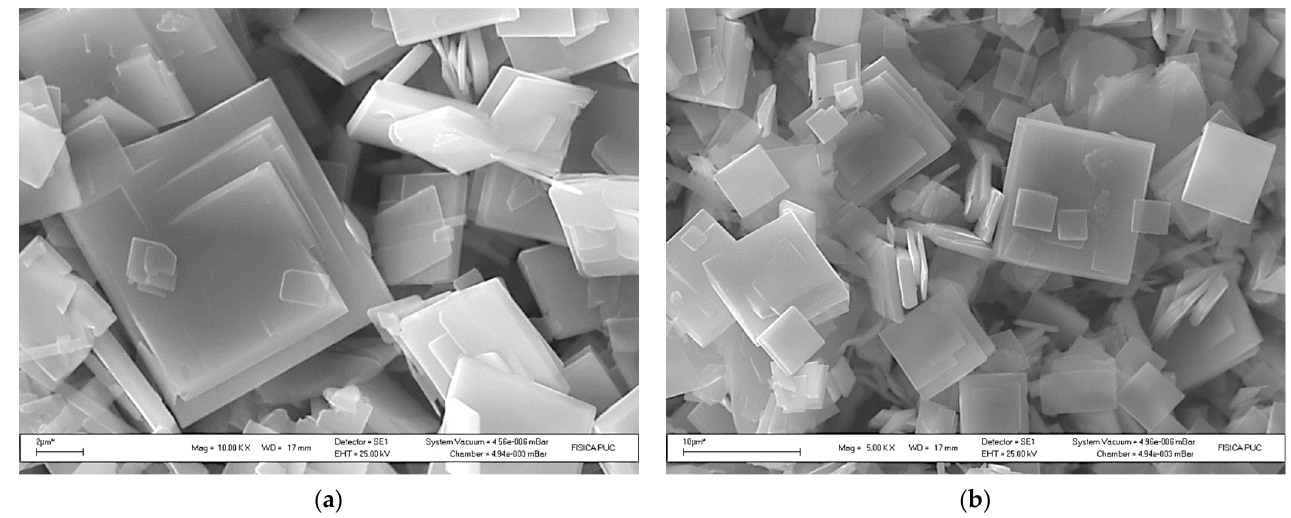
Figure 5. SEM micrographs of vanadium oxide (NH 4 ) 2 V 7 O 16 micro-squares (VOx-MSQ): ( a ) detailed square morphology; and ( b ) square morphology with different sizes.